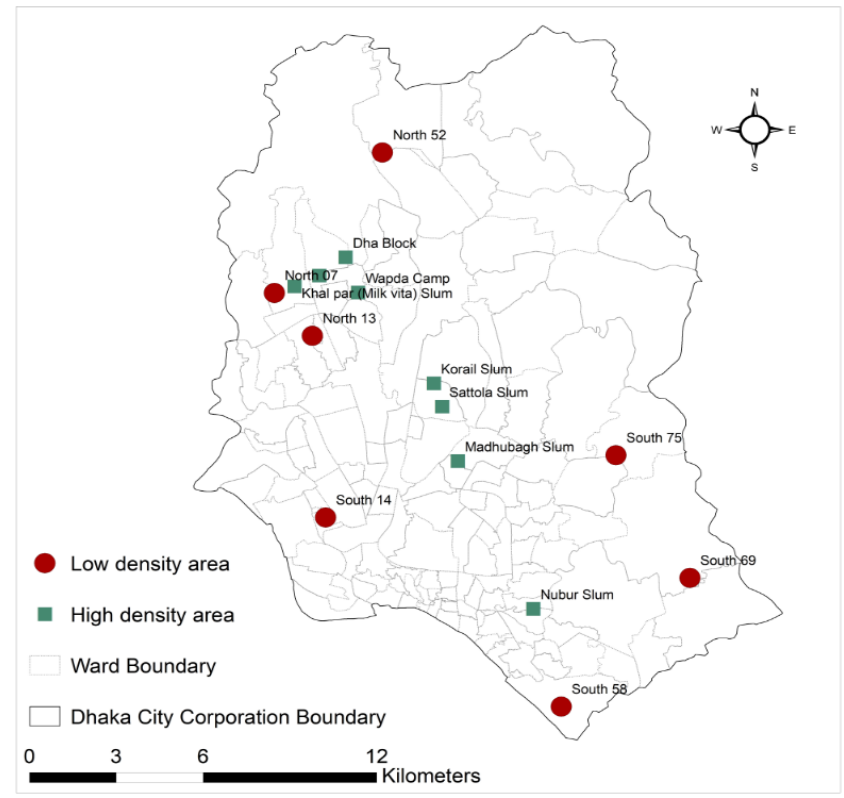
Figure 1. Map showing the location of the selected high- and low-density areas of Dhaka city. The total number of refusals was 107 in high-density areas and 40 in low-density areas. The primary reasons for not being able to collect the samples were absence from home (47%), refusal (38%), and migration (15%). Most of the enrolled contacts were in the 11–30 age groups in high- and low-density areas (Table 1). Enrollment of female contacts was higher in both high- (54%) and low-density (53%) areas (Table 1). The contacts had mostly a primary education level in both high- (40%) and low-density (52%) areas (Table 1). Ten percent of the contacts (10%, 50/497) were SARS-CoV-2-positive in high-density areas, and 20% (37/187) were SARS-CoV-2-positive in low-density areas. SARS-CoV-2 was identified at least in one of four nasopharyngeal specimens, collected on days 1, 7, 14, and